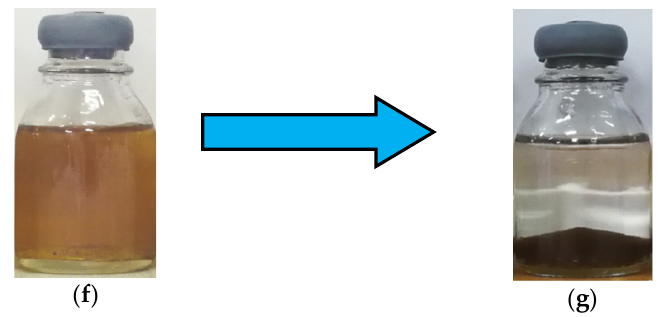
Figure 1. SEM ( a ) and TEM ( d ) of GO; SEM ( b ) of iron tailings; SEM ( c ) and TEM ( e ) of GO/iron tailings; solution image before adsorption ( f ); solution image after adsorption ( g ).